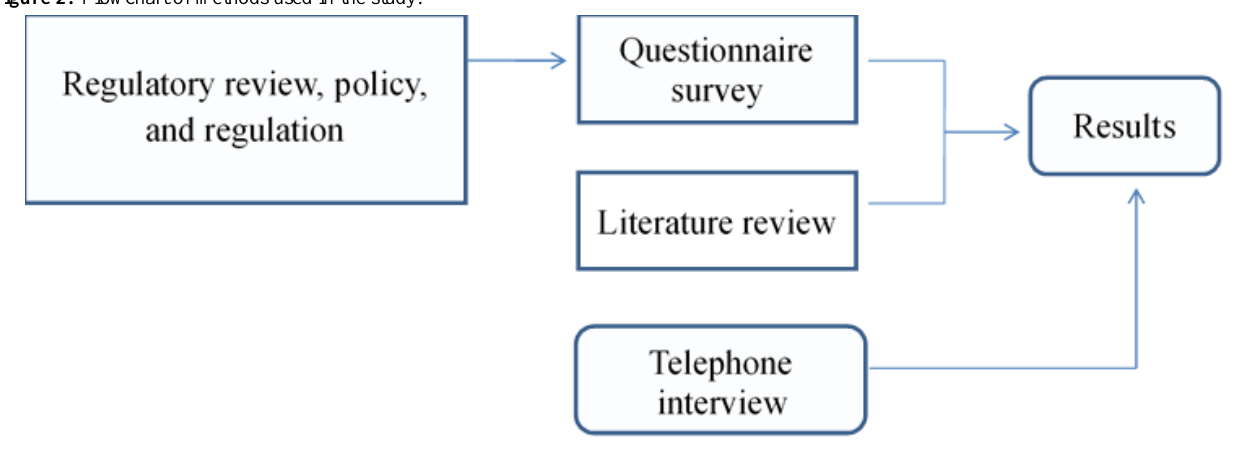
Figure 2. Flowchart of methods used in the